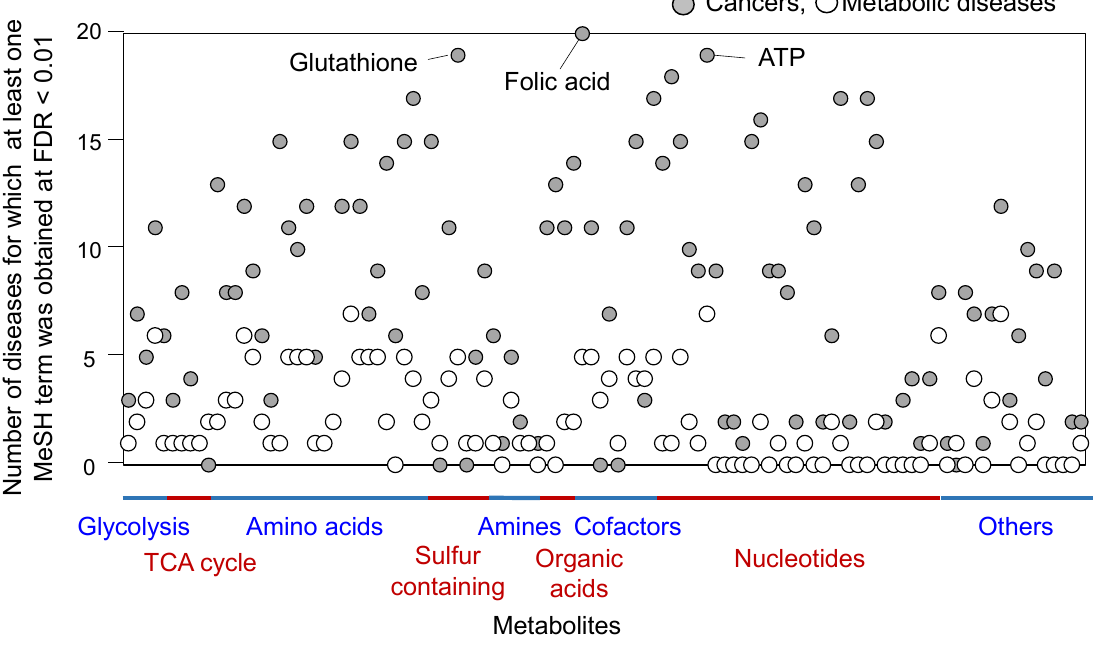
Figure 2. Connectivity between metabolites and diseases in literature. A pair of metabolite and disease was counted when at least one MeSH term was obtained by the developed method. The results were summarized for each metabolite against 20 cancers and 19 metabolic diseases. The complete figure with metabolite names is shown in Figure S2.